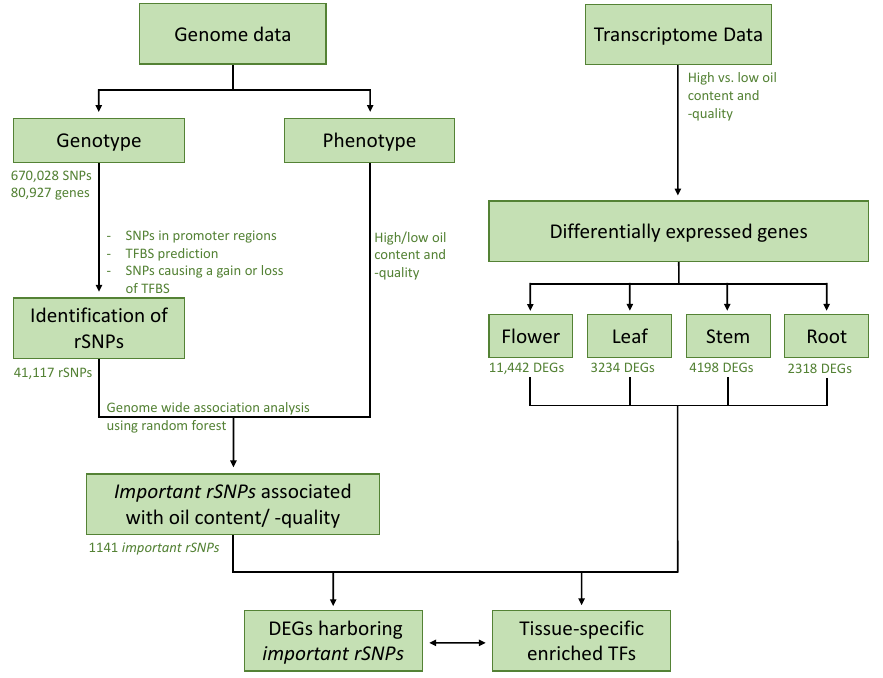
Figure 5. Flowchart of the analysis applied in this